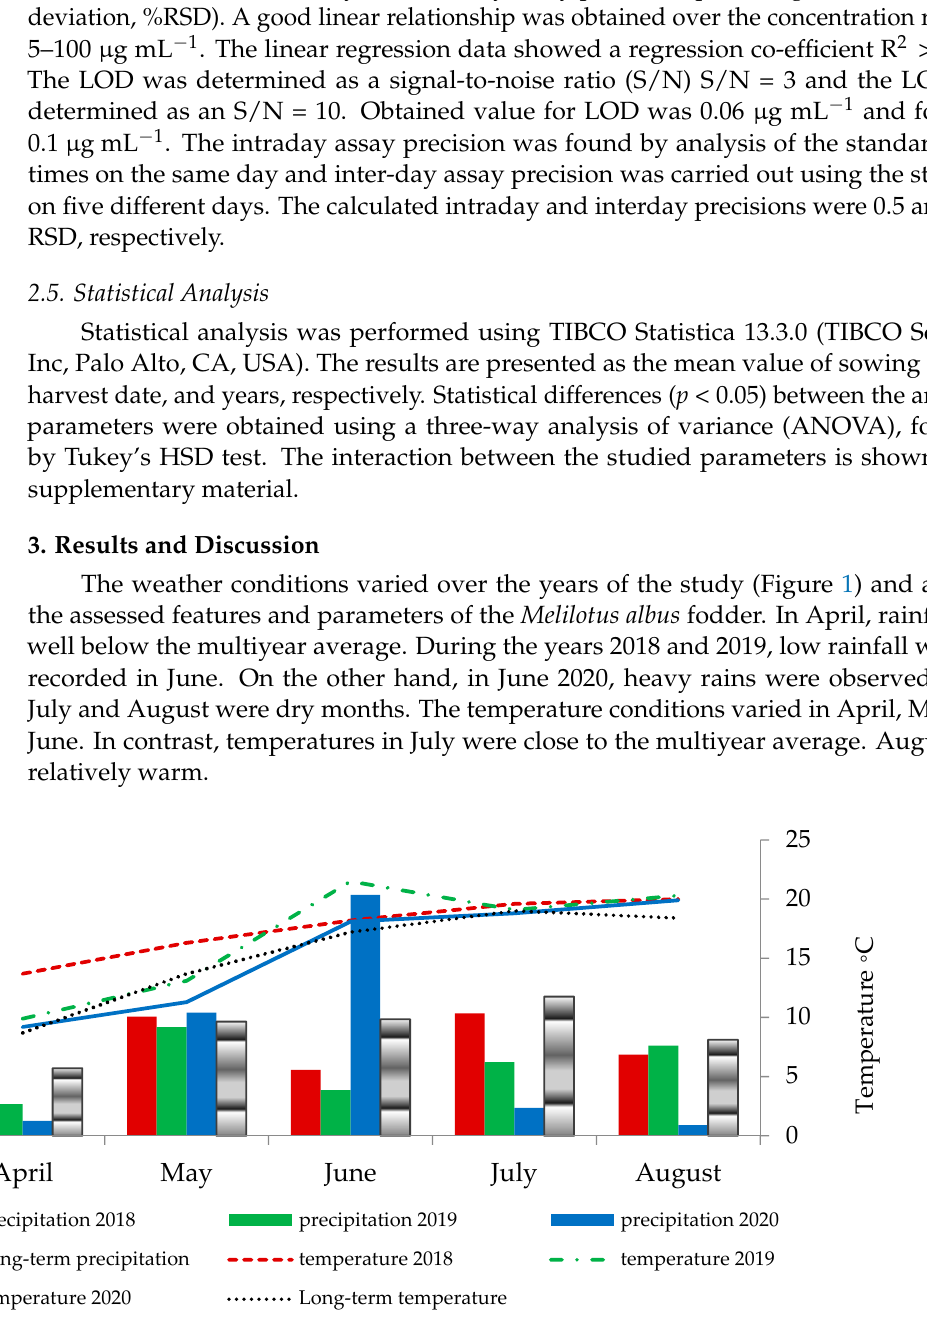
Figure 1. Weather conditions (mean temperature and precipitation) during the following growing seasons of Melilotus albus.